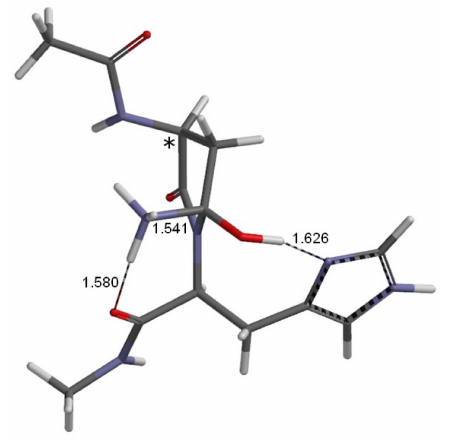
Figure 6. The optimized geometry of INT2, the protonated intermediate directly connected to TS2 ( ϕ N = ´ 174 ˝ , ψ N = ´ 105 ˝ , χ 1N = 88 ˝ , ϕ H = ´ 95 ˝ , ψ H = 144 ˝ , χ 1H = ´ 54 ˝ ). Relevant bond